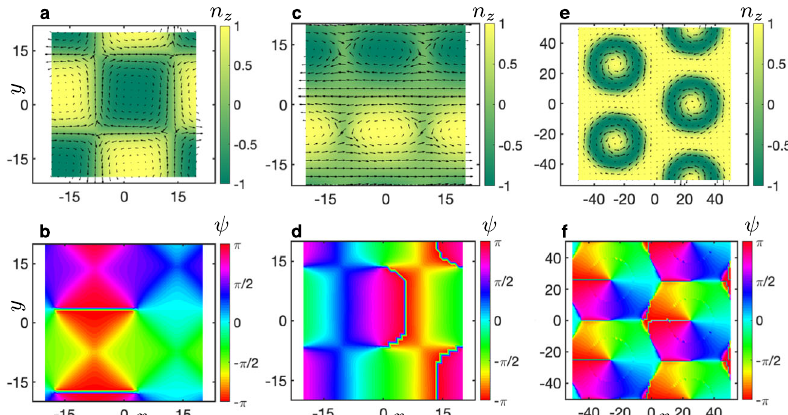
Fig. 5 Metastable modulated states. a , b The vortex array with a square lattice found at low applied magnetic fi elds ( H < H R ). c , d The alternating strings of merons and antimerons found at large applied magnetic fi elds ( H > H R ). e , f The non-singular hexagonal vortex crystal. The fi rst row (panels a , c and e ) shows the vector chirality n and the second row (panels b , d and f ) shows the corresponding angle ψ . In-plane components of n are indicated with arrows; n z and ψ are color-coded. The angle ψ is plotted modulo 2 π and the lines in the ψ -plots are branch cuts, across which ψ discontinuously changes by 2 π